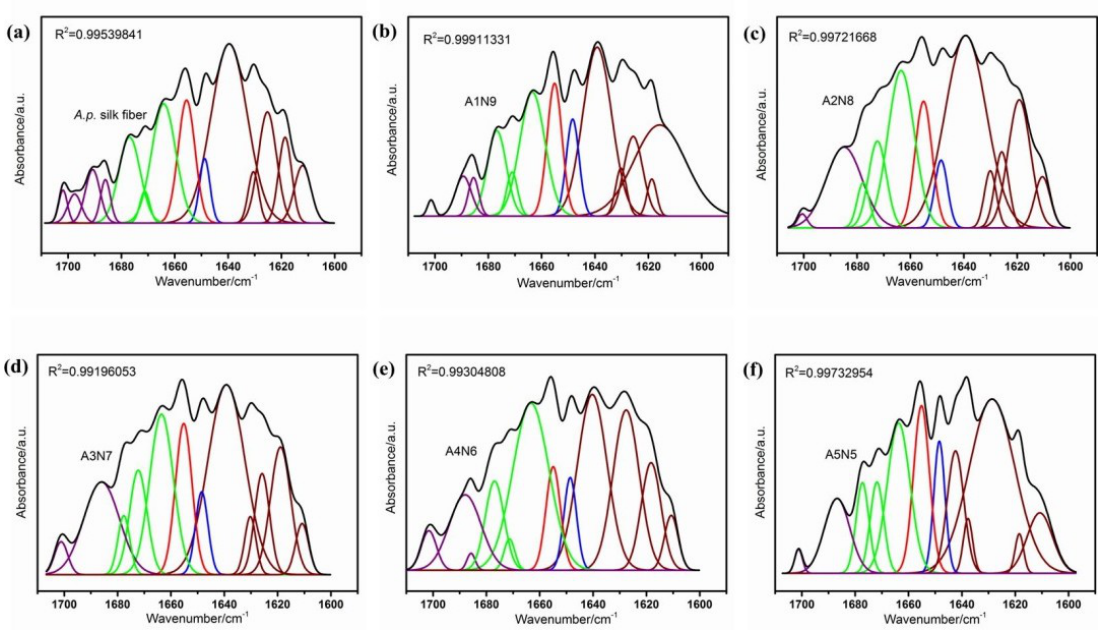
Figure 6. FTIR absorbance spectra and curve-fitting results in the amideI band for ( a ) A.pernyi silk fiber ( b – f ) composite hydrogels of different ASF content. Table 2. Secondary structure of ASF in the composite hydrogels with different mixing ratios.